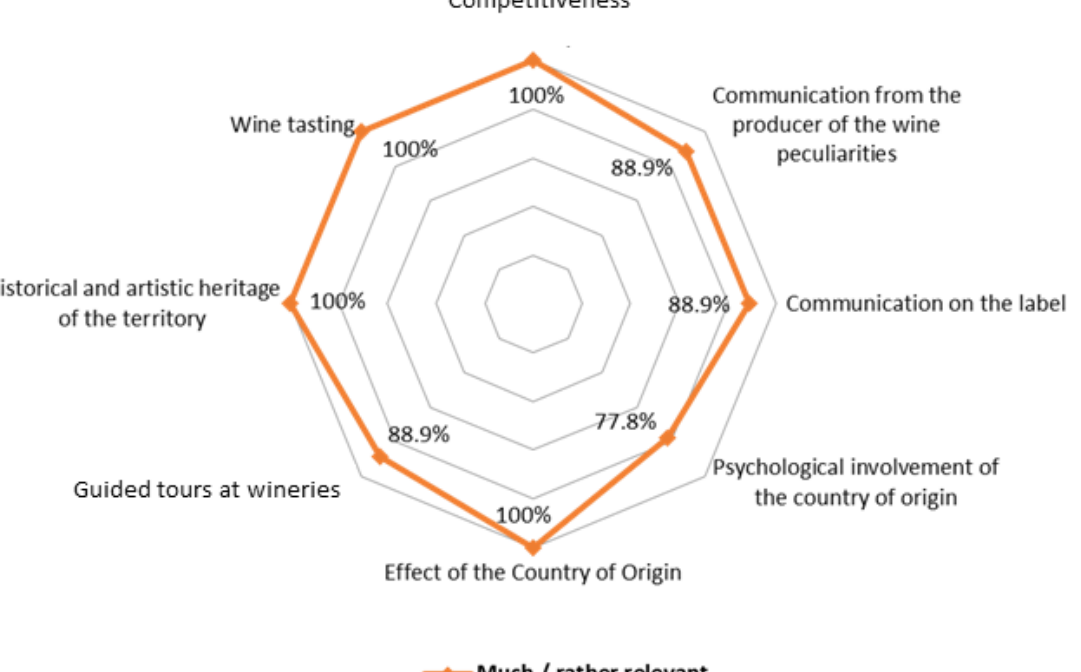
Figure 3. Most important factors to valorize the link between Etna Rosso DOC wine and the territory according to the panelists.